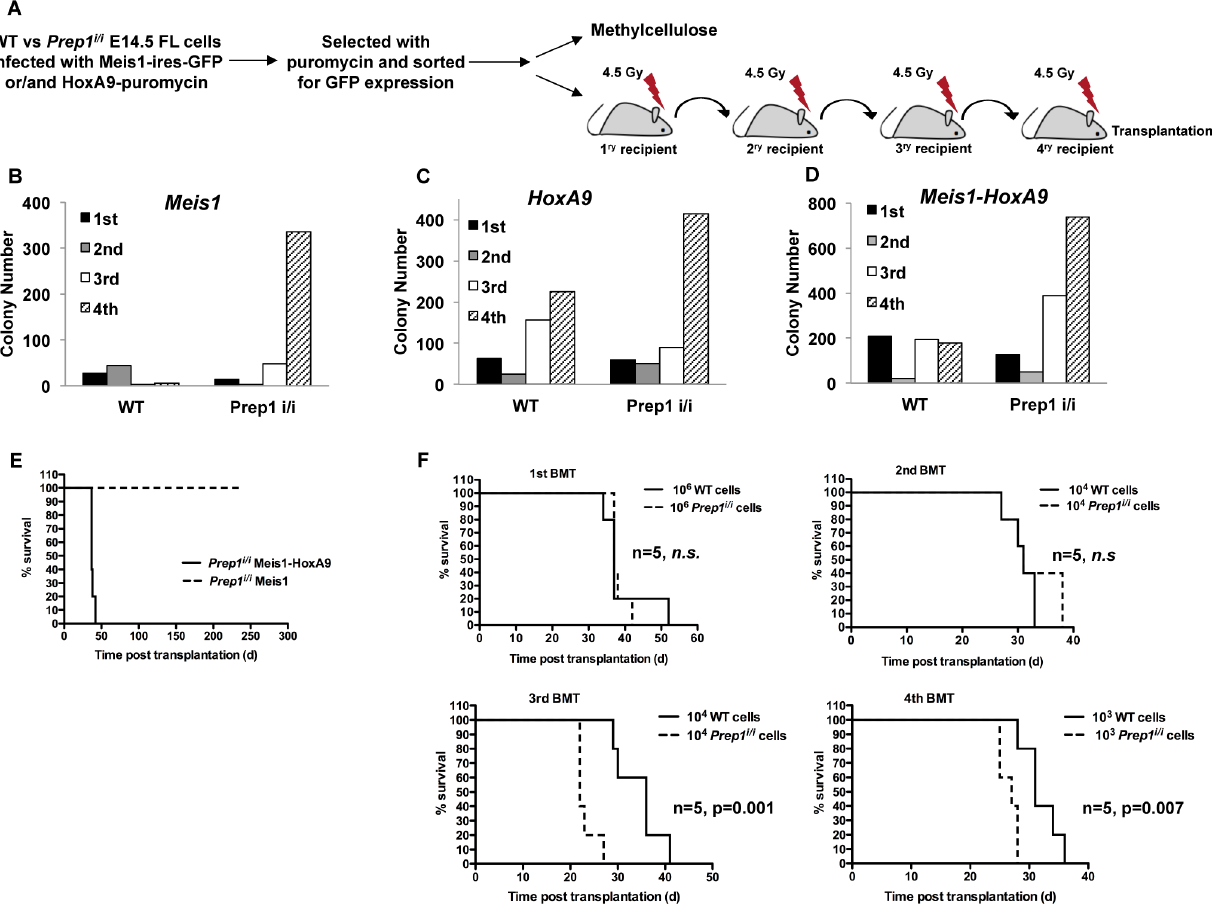
Figure 1. Prep1 absence accelerates Meis1-HoxA9 induced myeloid transformation and leukemogenesis. ( A ) Overview of the experimental strategy. FL cells taken from 14.5 WT or Prep1 i/i embryos were transduced with Meis1 ( B ) or HoxA9 ( C ) or co-transduced with both oncogenes ( D ) and serially plated in methylcellulose cultures every 7day. Results are shown as colony numbers per 5 6 10 4 plated cells for each round of culture. ( E ) Survival curves are shown for cohorts of mice transplanted with 1 6 10 6 of Prep1 i/i FL cells transduced with either Meis1 or Meis1-HoxA9 . Five mice for each group were used. ( F ) Survival curves are shown for cohorts of mice serially transplanted with the indicated numbers of WT or Prep1 i/i FL cells co-transduced with Meis1 and HoxA9 . Five mice per group were used. In the 1st and 2nd Bone marrow transplantation (BMT), the difference between the survival of the mice transplanted with either WT or Prep1 i/i transduced cells was not significant (n.s.). However, in the 3rd and 4th BMTs the p-values of mice survival transplanted with either WT or Prep1 i/i transduced cells were significant (p=0.001 and p=0.007,